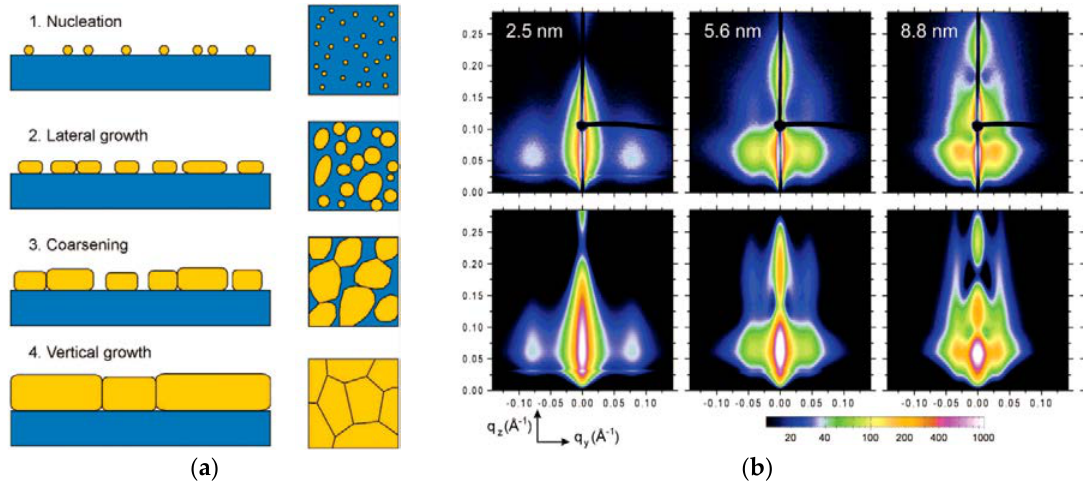
Figure 3. ( a ) Schematic representation of the Au cluster growth during sputter deposition on poly( N -vinylcarbazole) (PVK). Four growth regimes are visible with increasing surface coverage: nucleation (1), lateral cluster growth (2), coarsening (3), vertical cluster growth (4). ( b ) GISAXS pattern (top) and corresponding model-based simulations (bottom) obtained during stop-sputter deposition Au on a conducting polymer. The deposited layer thickness is indicated. Reproduced with permission from [198]. Copyright American Chemical Society, 2009.